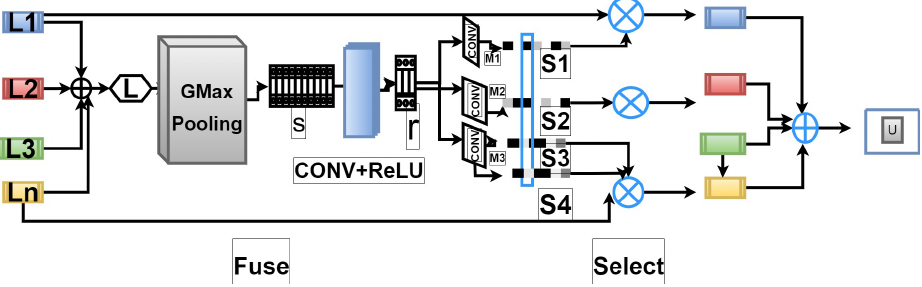
Figure 4. Updated Selective Kernel Feature Synthesis SKFS